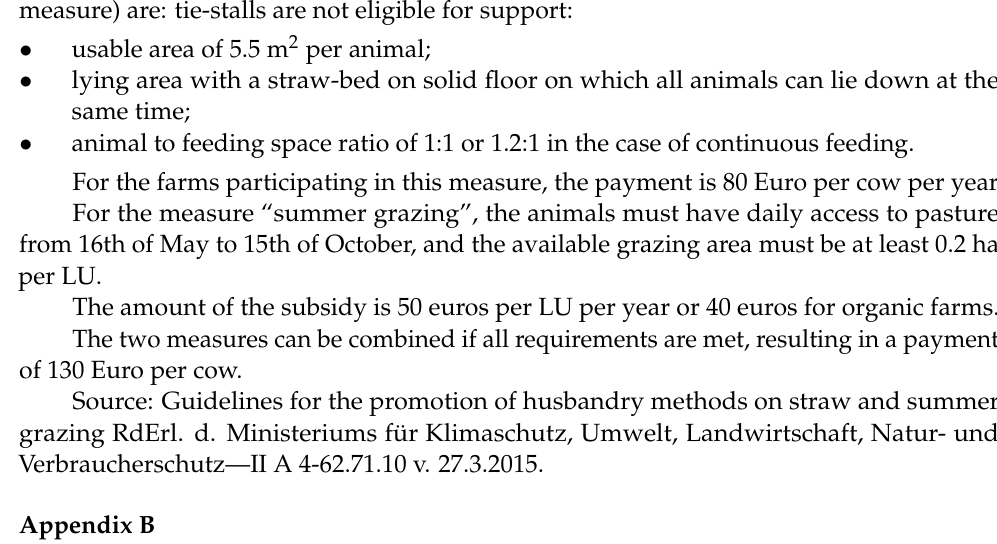
Table A1. Overall assessment of the results of Welfare Quality ® assessment in 115 project farms presented as WQ ® principles and criteria in mean values, range (min-max).